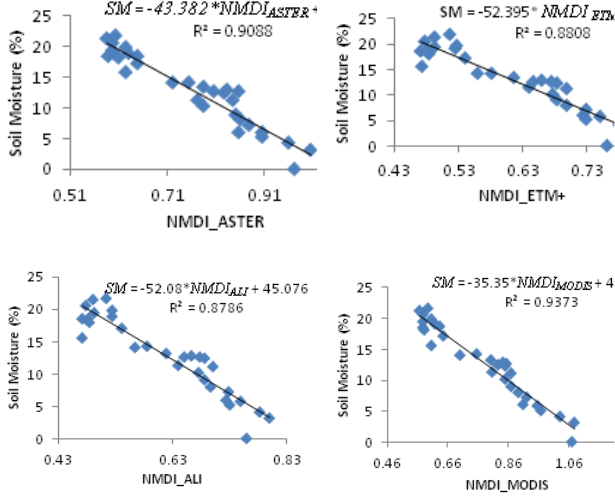
Fig. 8 Relationship between estimated soil moisture content with NMDI for MODIS , ASTER , ALI and ETM + sensors